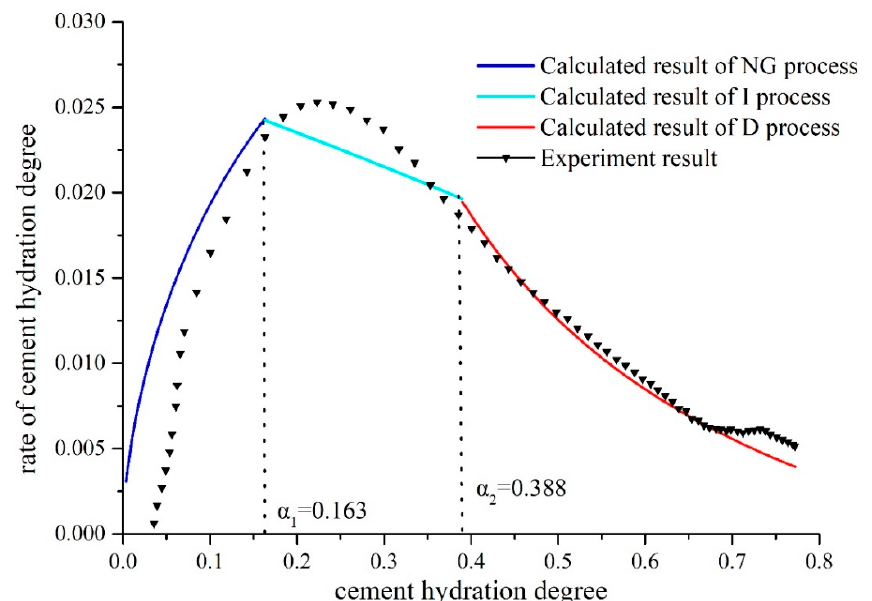
Figure 2. Comparison between the calculated and experimental results of the hydration process at 26.6 °C.